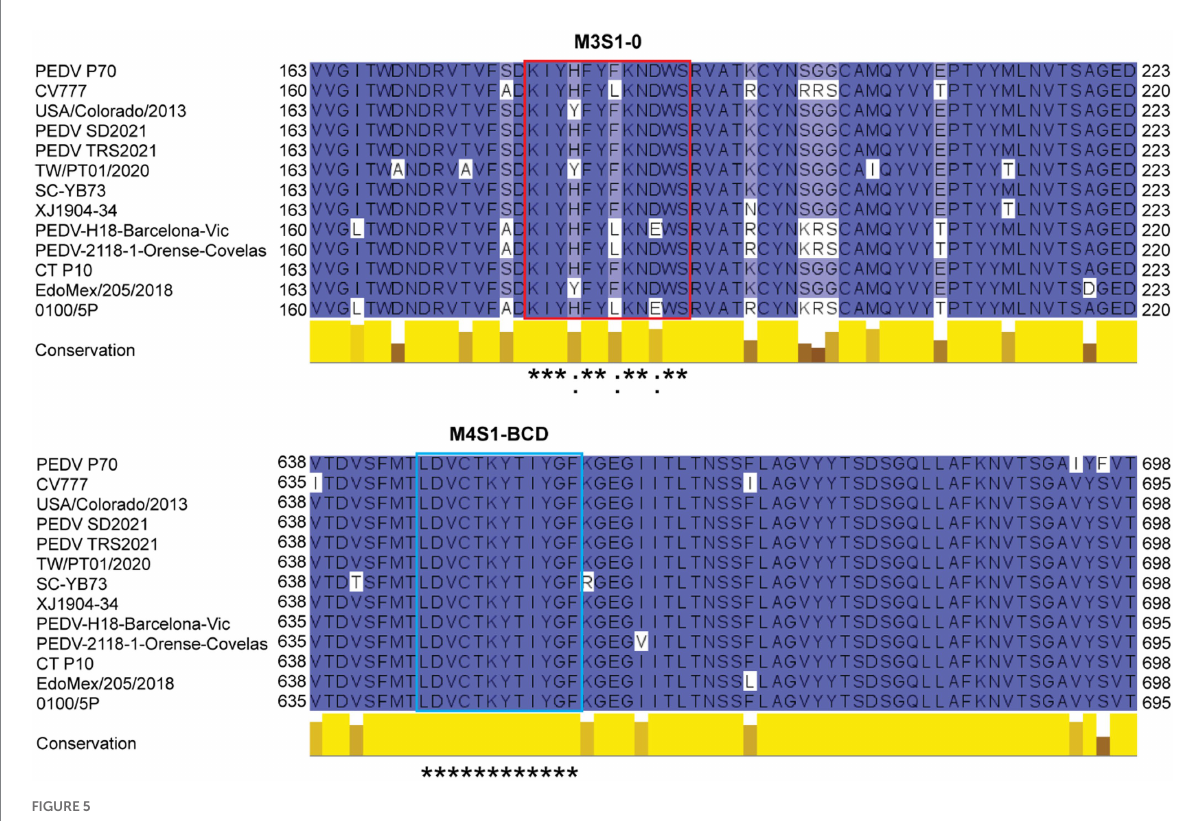
FIGURE 5 Multiple sequence alignment of amino acid sequences of spike proteins of various PEDV strains including PEDV P70 (a strain that was used in this study), CV777 (classical strain), USA/Colorado/2013 (prototype strain that was used for producing baculovirus-derived S subunit vaccine that caused severe enhancement; GenBank: KF272920.1), PEDV SD2021 (GenBank: UJZ92254.1), PEDV TRS2021 (GenBank: UJZ92268.1), TW/ PT01/2020 (GenBank: UOK15705.1), SC-YB73 (GenBank: QNL15619.1), XJ1904-34 (GenBank: UGN13709.1), PEDV-H18-Barcelona-Vic (GenBank: QKV43853.1), PEDV-2118-1-Orense-Covelas (GenBank: QKV43823.1), CT P10 (GenBank: QHB92364.1), EdoMex/205/2018 (GenBank: QQK84868.1), and 0100/5P (GenBank: UAJ21031.1). The M3S1–0 sequences (red box) are highly conserved, and M4S1-BCD sequences (blue box) are identical among these PEDV strains. *, identical amino acids; : , conserved amino